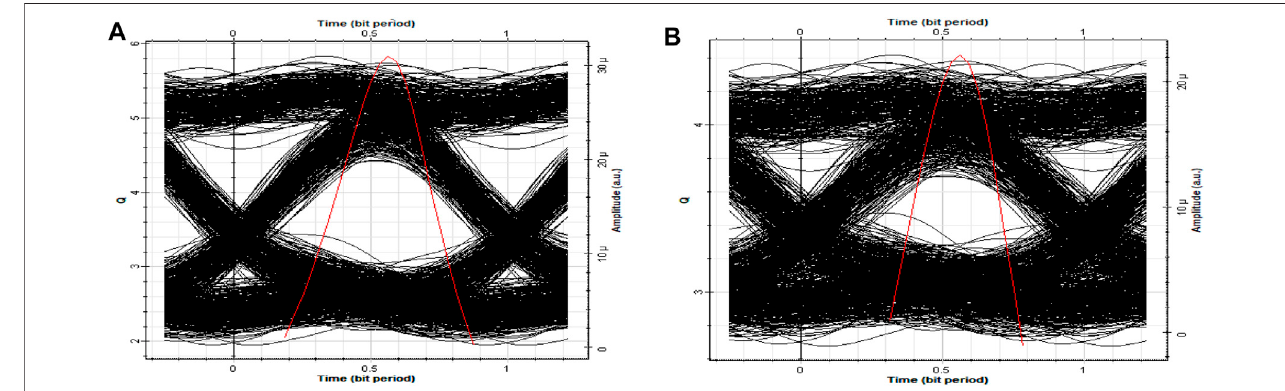
FIGURE4| EyediagramusingtheproposedNRZ-basedMDM-RoFSOlinkat14.5 kmtransmissiondistanceunderclearweatherforthe (A) HG00channeland (B) HG01 channel.